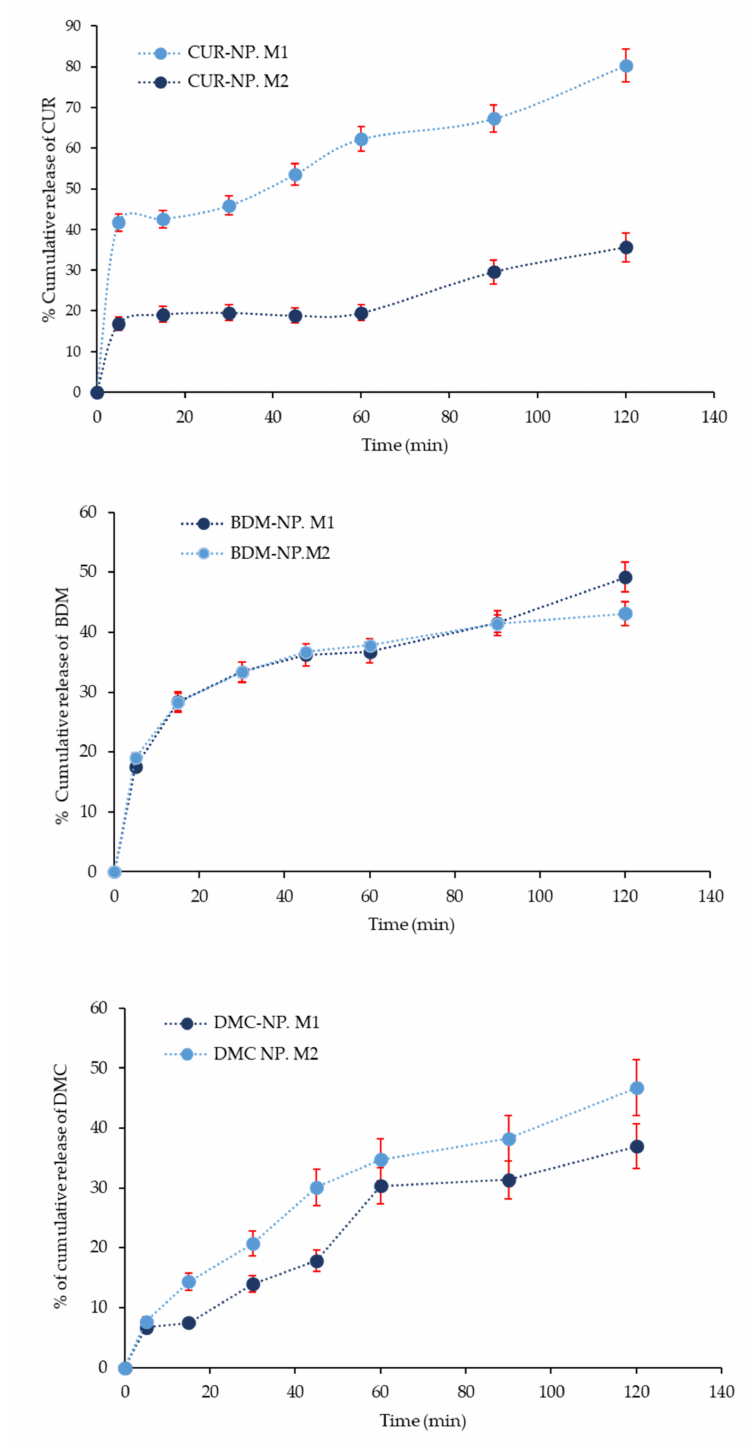
Figure 6. Release profile of CUR, DMC, and BDM from their respective hybrid NP formulation evaluated in two dissolution media M 1 and M 2 . Error bars (red) represent the standard deviation of CUR, DMC, and BDM concentrations in